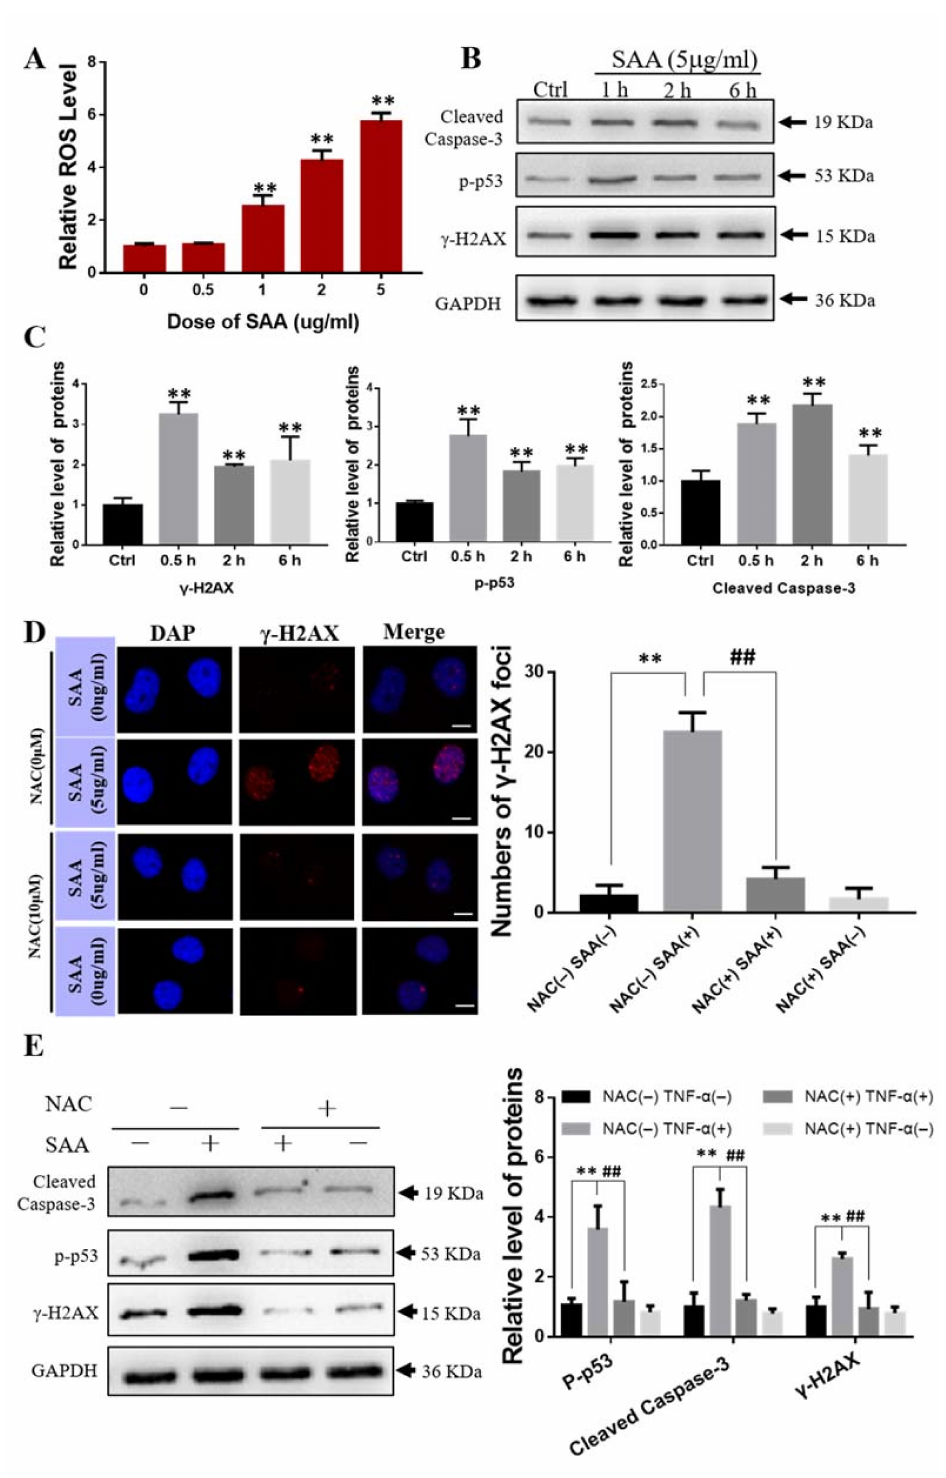
Figure 4. The effects of exogenous SAA on BMSCs. ( A ) Relative level of ROS in BMSCs treated with 0–5 µ g/mL of SAA for 1 h. ** p < 0.01 compared with control group. ( B , C ) Western blot analysis of the protein expression of Cleaved caspase-3, p-p53 and γ -H2AX in BMSCs after the treatment with SAA. ** p < 0.01 compared with control group. ( D ) NAC mitigated SAA-induced -H2AX foci formation in BMSCs. Cells were treated with 10 µ M NAC for 0.5 h before SAA treatment for 1 h. Bar = 10 µ m. ( E ) Western blot assay of the protein expressions of Cleaved caspase-3, p-p53 and -H2AX in BMSCs treated with SAA and/or NAC. ** p < 0.01 compared with NAC ( − ) SAA ( − ) group; ## p < 0.01 compared with NAC (+) SAA (+) group. Each experiment was repeated at least three